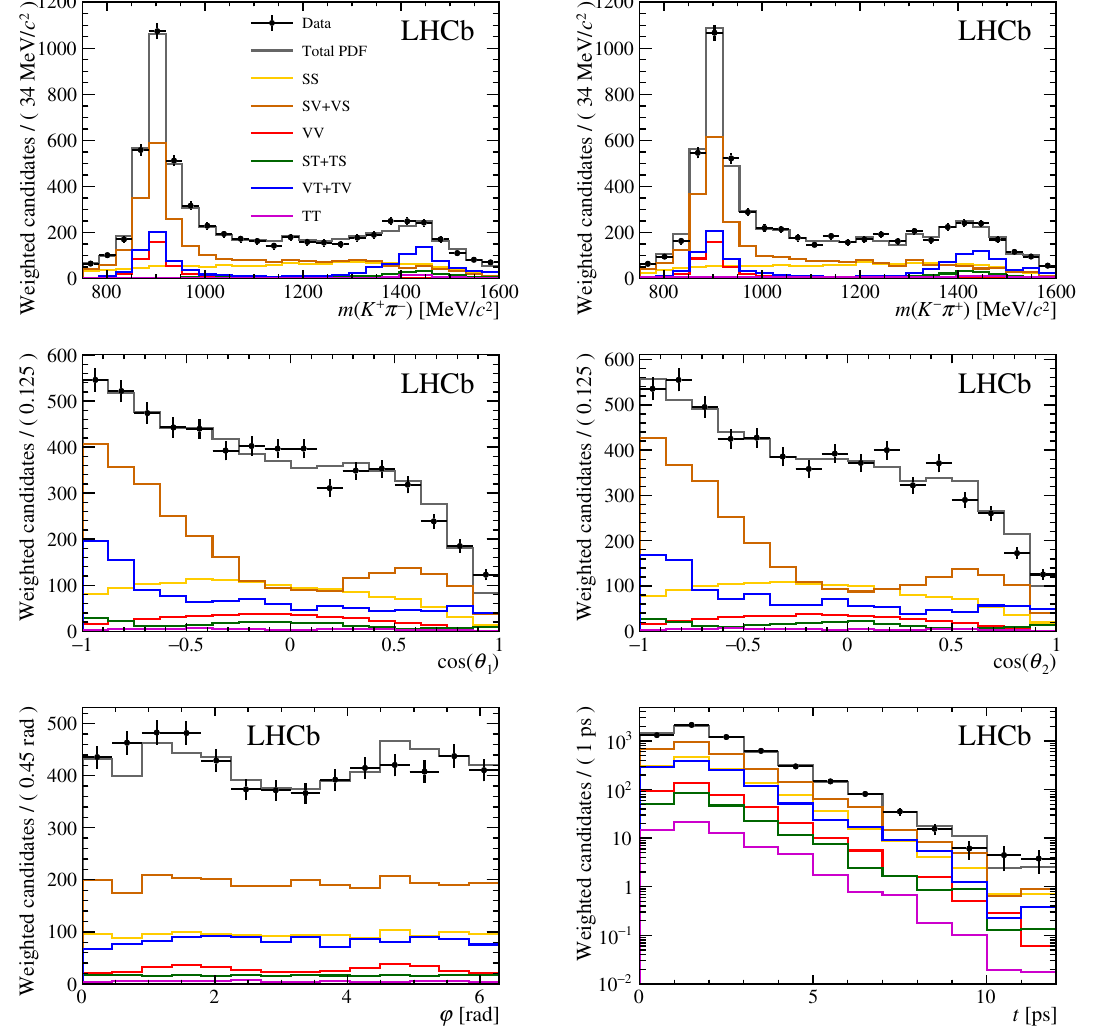
Figure 7 . One-dimensional projections of the decay-time-dependent, (cid:13)avour-tagged (cid:12)t to (black points) the sPlot weighted data for (top row) the two ( K(cid:25) ) invariant masses, (middle row) the two ( K(cid:25) ) decay plane angles, (bottom left) the angle between the two ( K; (cid:25) ) decay planes and (bottom right) the decay-time. The solid gray line represents the total (cid:12)t model along with the CP -averaged components for each contributing